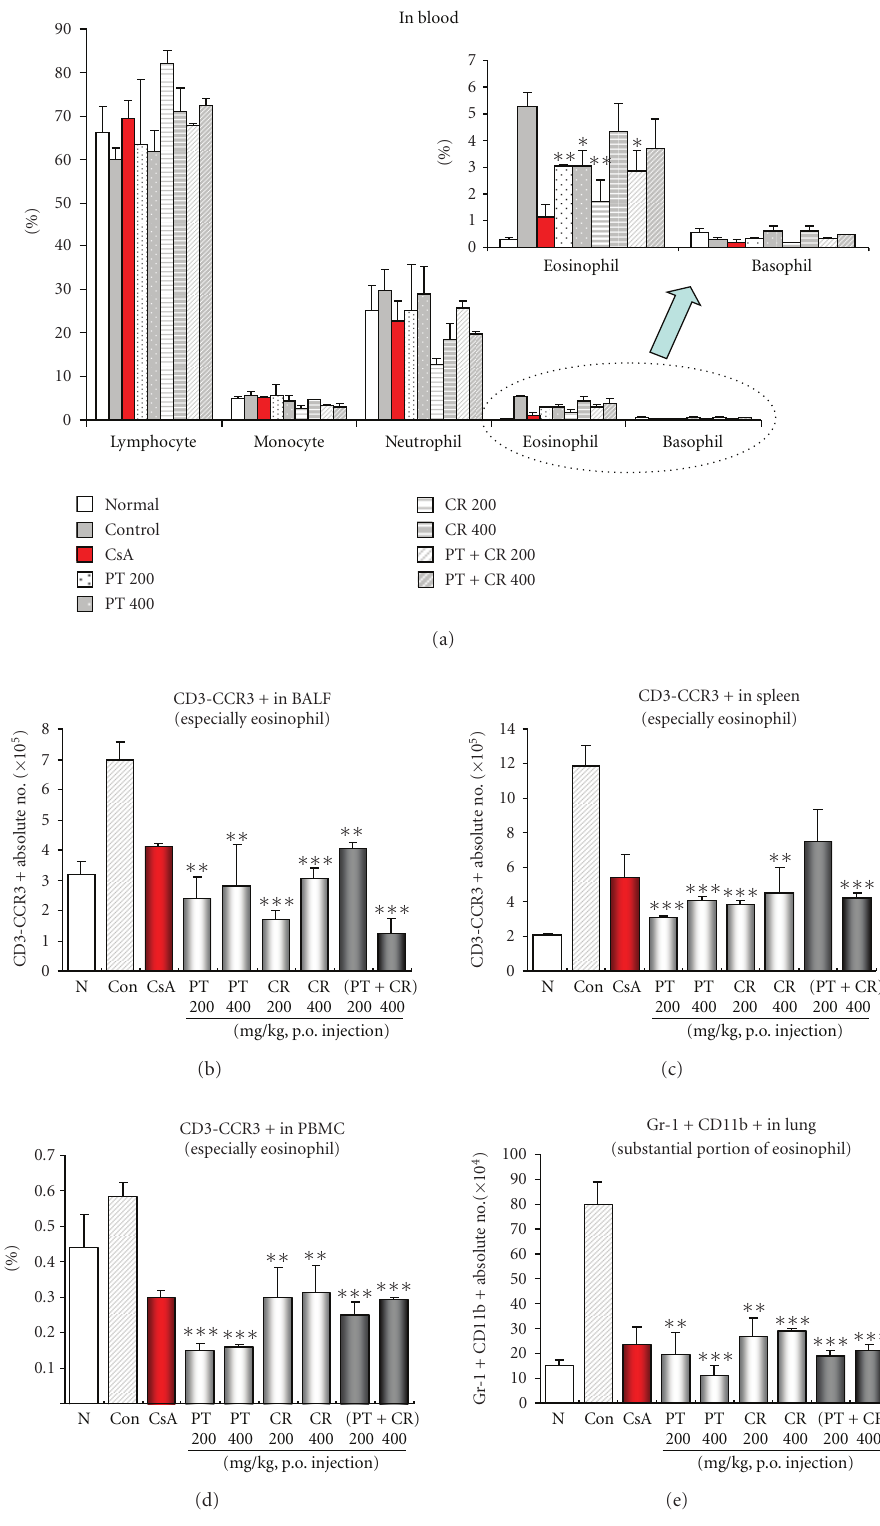
Figure 3: Quantification by means of FACS analysis of CD3-CCR3+ cell subtypes in BALF, spleen, lung, and PBMC. Absolute number of CD3-CCR3+ cell subtypes in BALF, spleen, lung and PBMC were counted (seen materials and methods). The results are expressed the mean ± S.E ( N = 5). Statistically significant value compared with control group data by ANOVA or unpaired Student’s t -test ( ∗ P < . 05, ∗∗ P < . 01, ∗∗∗ P < . 001). N: Normal Balb/c mice, CT: Ovalbumin inhalation (control group), CsA: OVA + CsA (10mg/kg), OVA + PT(200, 400mg/kg), OVA + CR(200, 400 mg/kg), OVA + (PT + CR) (200,